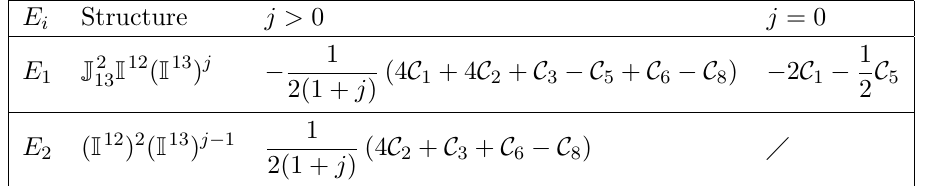
Table 12 . Expansion of the supersymmetric correlator in the component spin (0 ; 1 ( j + 1)). The result for j = 1 is obtained by setting 2